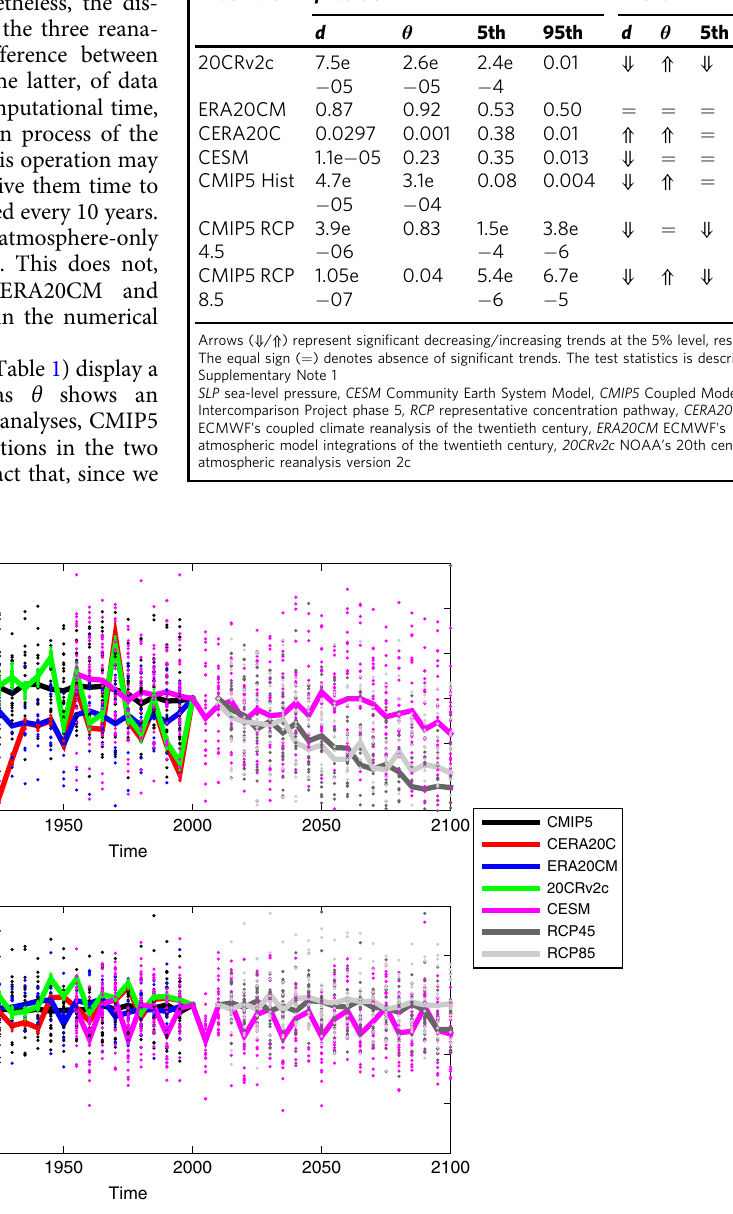
Table 1 Mann – Kendall test p values for d SLP , θ and the 5th